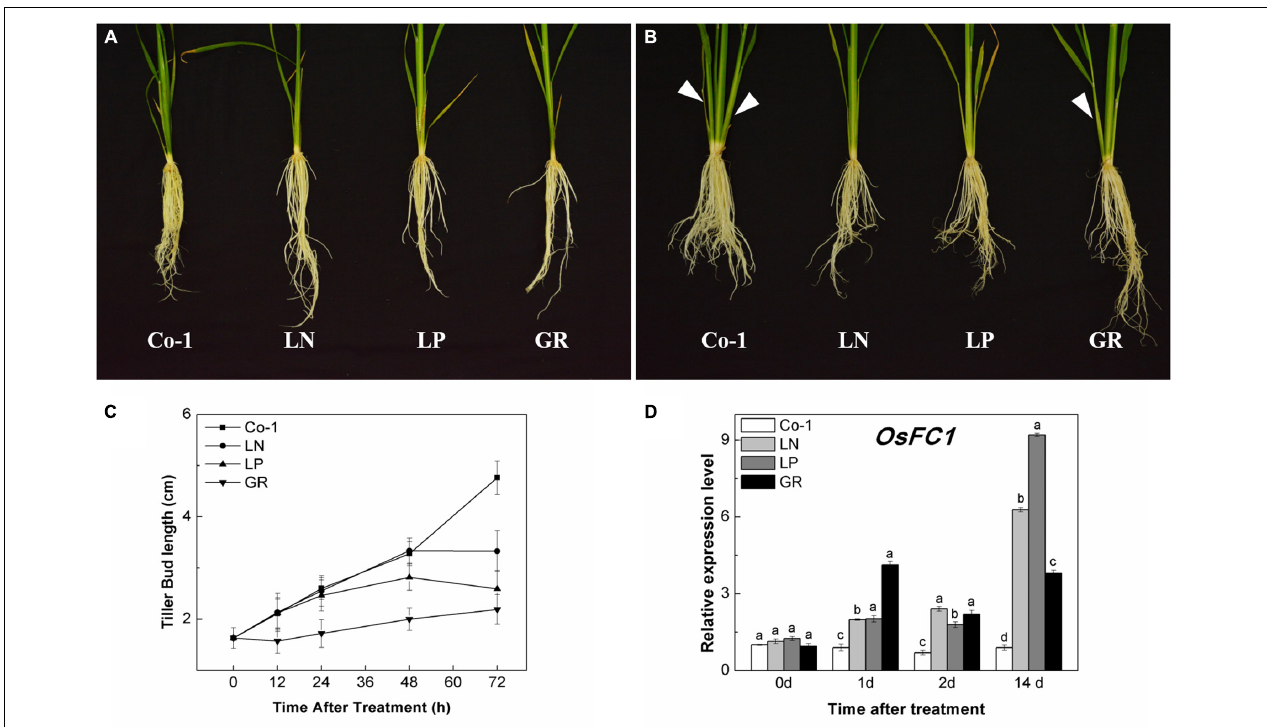
FIGURE 1 | Effects of LN, LP, and GR treatments on the growth of rice tiller and OsFC1 expression in tiller bud. (A) Rice plant before treatment; (B) rice plants after 2 weeks of treatment; (C) outgrowth of rice tiller buds at the fifth leaf axils; and (D) OsFC1 expression in tiller buds at the fifth leaf axils. The arrows in (A) and (B) refer to the growth of new tillers within 2 weeks. Co-1 contains 2.5 mM N and 300 µ M P in a nutrient solution, LN contains 0.02 mM N and 300 µ M P in a nutrient solution, LP contains 2.5 mM N and 2 µ M P in a nutrient solution, GR contains 2.5 mM N, 300 µ M P, and 2 µ M rac-GR24 in a nutrient solution. The expression of OsFC1 in the tiller buds at 0, 1, 2, and 14 days after each treatment is represented relative to the Co-1 at 0 day. Vertical bars (C) represent mean ± standard error ( n = 60). The value (D) obtained from the control treatment at 0 h after treatment was arbitrarily set at 1.0. Quantitative real-time PCR was performed in triplicate (three biological replicates), and mean values with SD are